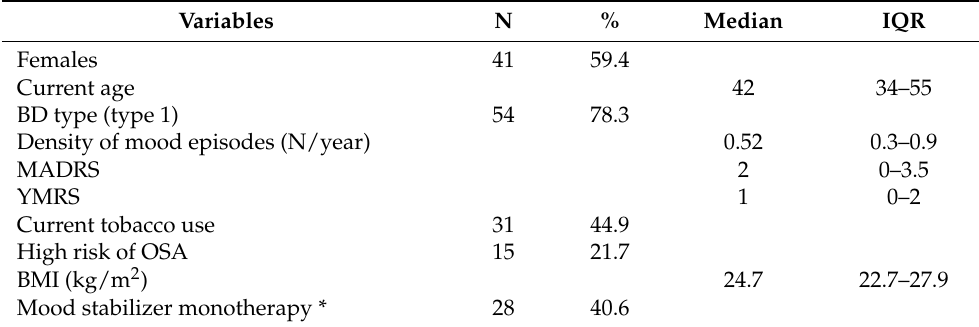
Table 1. Socio-demographic and clinical characteristics of the sample (N = 69).